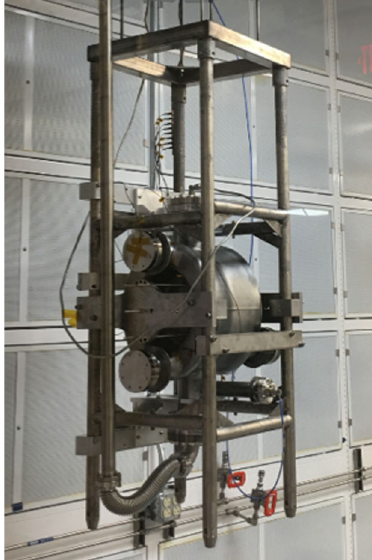
FIG. 10. Stiffening frame for DQW cold tests at Jefferson Lab.